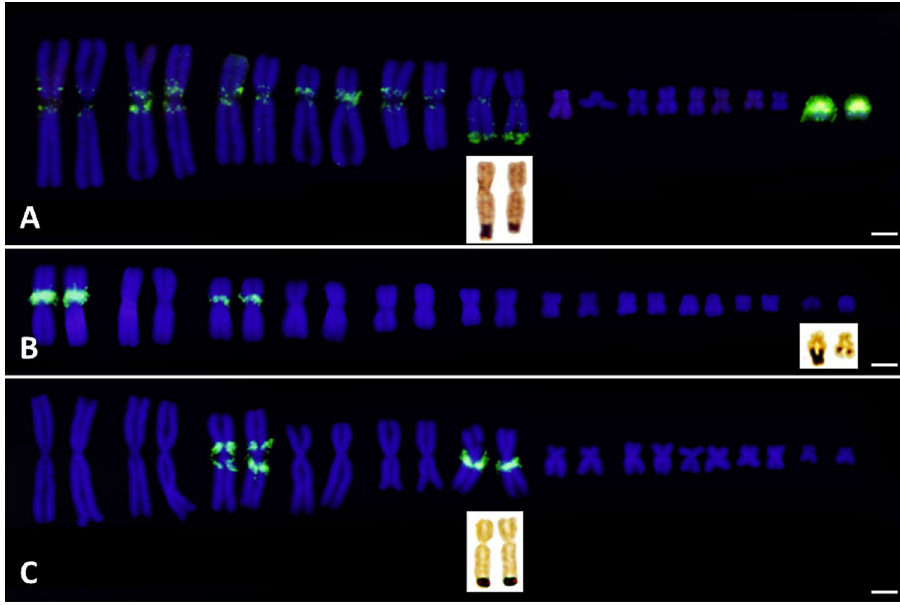
Figure 5. Karyotypes of Bufo spinosus ( a ), Epidalea calamita ( b ) and Bufotes viridis ( c ) hybridized with species- specific BamHI-800 sequences. The position of the NOR is indicated with an inset showing the corresponding Ag-stained chromosome pair. Scale bar equivalent to 2.5